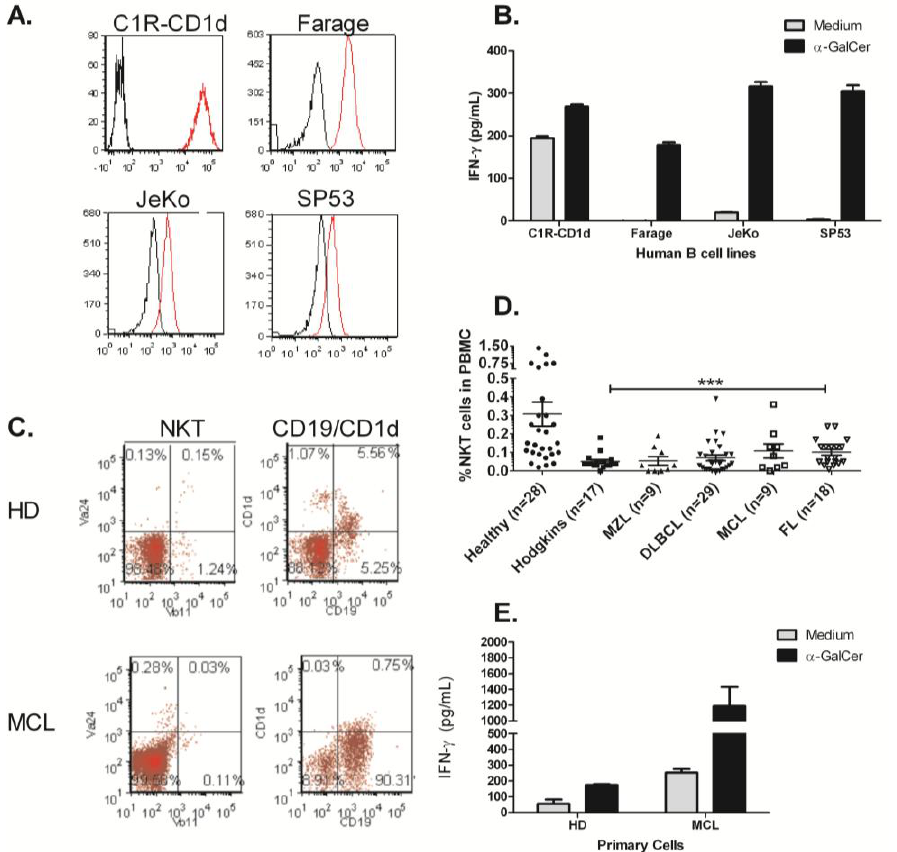
Figure 2. Healthy human NKT cells are stimulated by human B cell lymphomas, but circulating NKT cells are reduced in lymphoma patients. ( A ) Differential CD1d expression in human B cell lymphoma cell lines. Human B cell lymphoma cell lines were analyzed for surface expression of CD1d by flow cytometry. Cells were stained with PE-labeled human CD1d specific clone CD51.1 (red histograms). Isotype staining was performed to demonstrate specificity (black histograms). C1R-CD1d served as the positive control; ( B ) Primary human NKT cells were cocultured with human B cell lymphomas in the absence or presence of antigen- α-GalCer. Cytokine production following stimulation with C1R-CD1d served as the positive control; ( C ) Circulating NKT cells are reduced in MCL patients. PBMC were isolated from healthy donors (HD) and mantle cell lymphoma (MCL) patients and stained for flow cytometry; ( D ) Peripheral blood mononuclear cells (PBMC) were isolated from healthy donors and cancer patients. Cells were stained for Vα24 + Vβ11 + TCR and analyzed by FACS. Scatterplots demonstrate the variation in the percentages of NKT cells. MZL-marginal zone lymphoma; DLBCL-diffuse large B cell lymphoma; MCL- mantle cell lymphoma; FL-follicular lymphoma. % NKT cells of healthy donors vs. lymphoma patients; Statistical analysis was performed using one way ANOVA *** p < 0.001; ( E ) Primary NKT cells expanded from a healthy donor were co-cultured with B cells isolated from a healthy donor or a mantle cell lymphoma (MCL) patient in the presence or absence of α-GalCer. Culture supernatants were harvested and ELISA was used to measure IFN-γ production. Data are representative of three independent